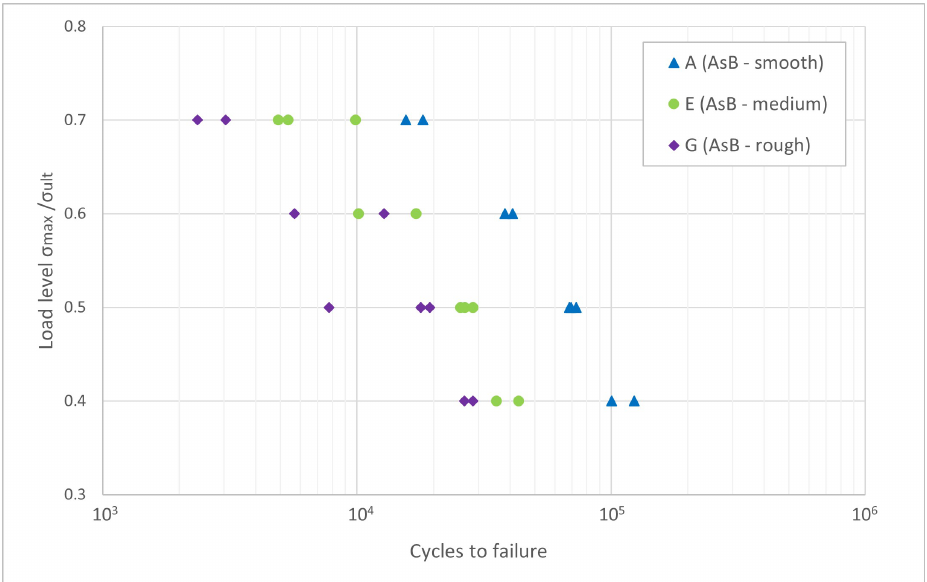
Figure 8. σ − N -curve for surface conditions A (AsB-smooth), E (AsB-medium) and G (AsB-rough), reference stress σ ult = 392 MPa. Reproduced from [52].